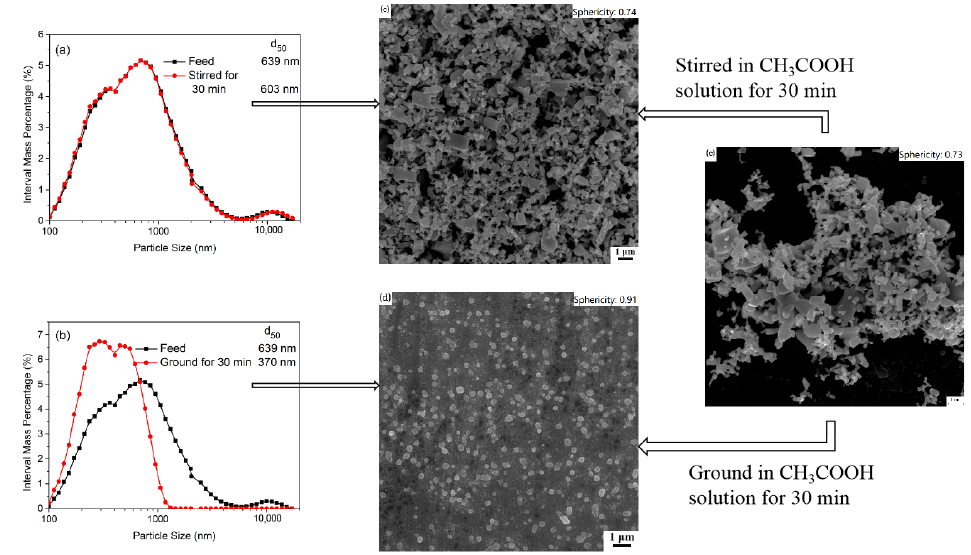
Figure 3. The PSD and SEM pictures of ZnO particles stirred or ground for 30 min in a CH 3 COOH solution. ( a ) the interval mass distribution of ZnO particles stirred for 30 min; ( b ) the interval mass distribution of ZnO particles ground for 30 min; ( c ) SEM image of ZnO particles stirred for 30 min; ( d ) SEM image of ZnO particlesground for 30 min; ( e ) SEM image of ZnO raw material. Figure 4 shows the PSD of ZnO particles ground for 30 min in CH 3 COOH, C 6 H 8 O 7 , HCl and NaOH at di ff erent concentrations. The corresponding d 50 , n and sphericity are shown in Table 3. Clearly, compared to the particles ground in C 6 H 8 O 7 , HCl or NaOH solutions, the particles ground in the CH 3 COOH solution at an optimum concentration of 0.010 mol/L had a fi ner particle size (i.e., d 50 = 370 nm), a narrower size distribution (n = 2.28) and a higher sphericity value (i.e., 0.91). The particles ground in other solutions at the concentration of 0.100 mol/L were larger in size, had a wider size distribution and had less sphericity. In these cases, the coarser particles remained and even increased in num- ber at a higher concentration. This phenomenon could be caused by the particle aggrega- tion caused at a lower pH value and a higher ion concentration [18]. The particle aggrega- tion could a ff ect the grinding performance and weaken the e ff ect of chemical dissolution. A lower concentration of acid can promote the grinding and the dissolution e ffi ciency. The particles ground in the C 6 H 8 O 7 solutions at di ff erent concentrations also had a fi ner size and a narrower PSD, and the sphericity increased slightly as the concentration of C 6 H 8 O 7 increased. This is because citrate anions adsorbed on the particle’s surface can increase the suspension stability [31] and also the dissolution e ff ect of C 6 H 8 O 7 , thereby enhancing the grinding performance. In Figure 4d, the NaOH concentration is shown to have a slight in fl uence on the grinding performance.